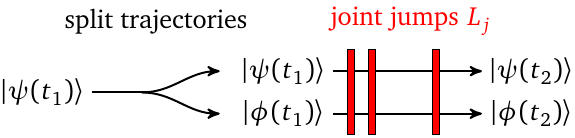
Figure 7: Sketch of the creation of one sample for the computation of two-time